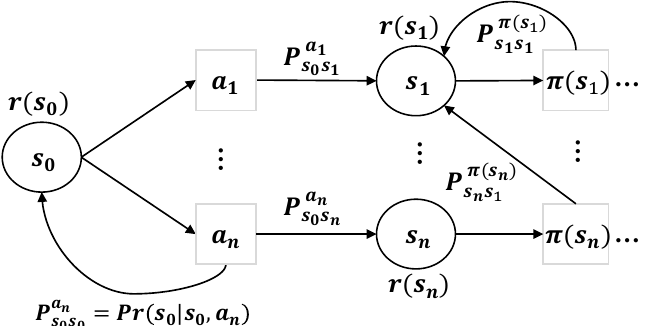
Figure 1. An example of MDP, where a circle represents a state and a square represents an action that is available in the state. P represents an unknown state transition probability, a reward is denoted by r , and π is the